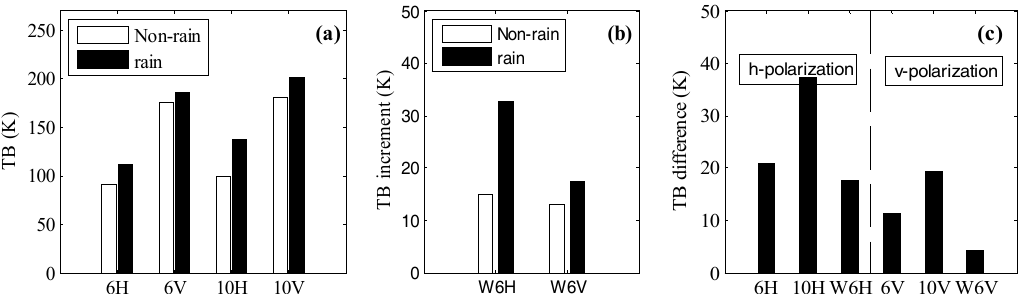
Figure 11 . Comparison of radiance characteristics for rain area and non-rain area over hurricane Bill on 21 August 2009, at 0555 to 0559 UTC. ( a ) Average brightness temperature of each selected channel; ( b ) average brightness temperature increment of W6H (W6V); and ( c ) brightness temperature difference caused by rain. Figure 12 shows the wind speed retrieval results of hurricane Bill over three continuous days (19–21 August). The sequence of figures clearly shows the intensification process of hurricane Bill. Figure 12. Retrieved wind speeds using the AMSR-E 6 and 10 GHz h-pol and v-pol brightness temperature data over hurricane Bill on ( a ) 19 August 2009, at 1650 to 1654 UTC; ( b ) 20 August 2009, at 0512 to 0516 UTC; and ( c ) 21 August 2009, at 0555 to 0559 UTC. 4.3. Rain Effects on Wind Retrieval Rain is known to both attenuate and backscatter microwave signals. Brightness temperature acquired at higher frequencies (e.g., 36.5 GHz) saturates quickly and then decreases for most of the rainfall range. Brightness temperatures acquired at low frequencies, such as 6.9 and 10.7 GHz, are less sensitive to atmosphere and rain. Therefore, we could use the low-frequency channel brightness